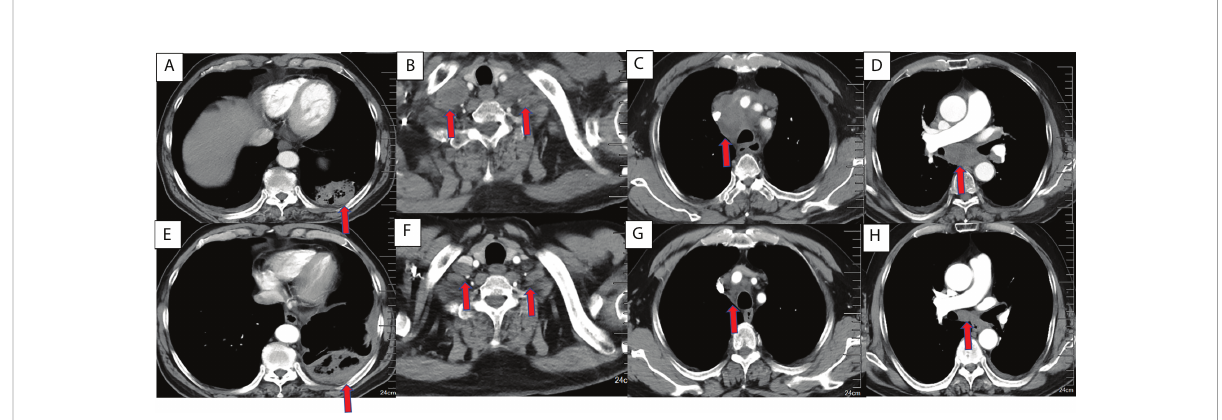
FIGURE 1 Chest CT fi ndings of a 63-year-old male squamous cell lung cancer patient with a PD-L1 TPS of 1% who underwent MWA and camrelizumab monotherapy. (A – D) Baseline chest CT showing the primary tumor and lymph node metastases. (A) The primary tumor was located in the left lower lobe. (B) Bilateral supraclavicular lymph node metastases. (C, D) Mediastinal lymph node metastases in the 2R, 4R, 5, and 7 zones. (E – H) CT 2 months post-ablation and after four cycles of camrelizumab. (E) . Complete ablation was achieved in the primary tumor. (F – H) . Bilateral supraclavicular mediastinal lymph node metastases decreased dramatically. PD-L1, programmed death ligand-1; TPS, tumor proportion score; MWA, microwave ablation; CT, computed tomography.